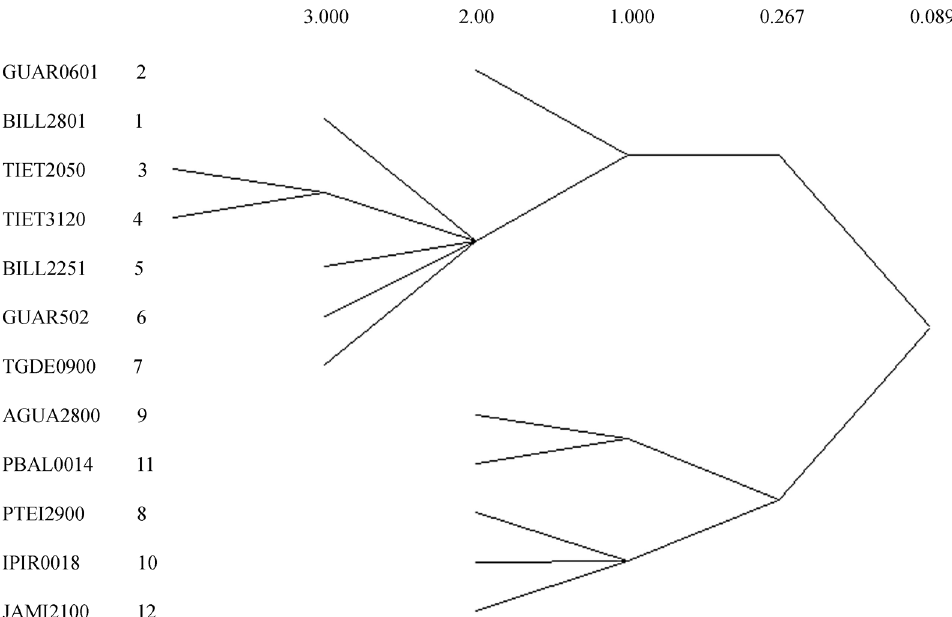
Figure 4 - Dendrogram obtained using the w-clique metric, showing water body